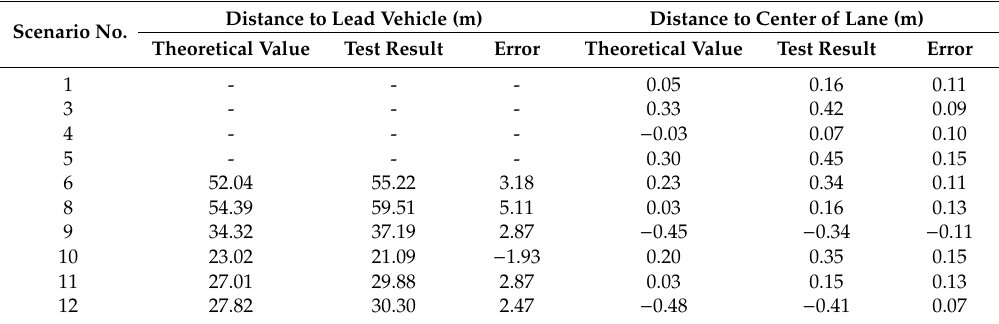
Table 4. Maximum calculation errors per